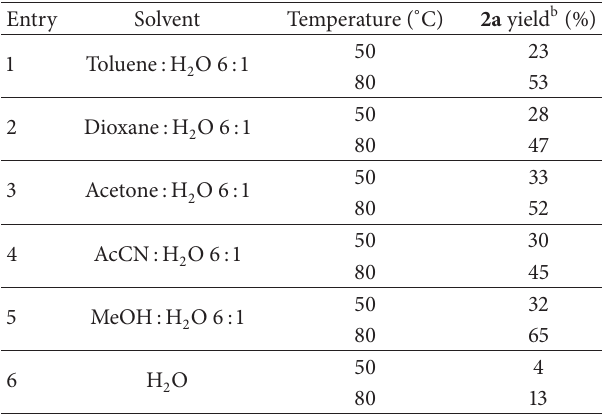
Table 2: Effects of (NH